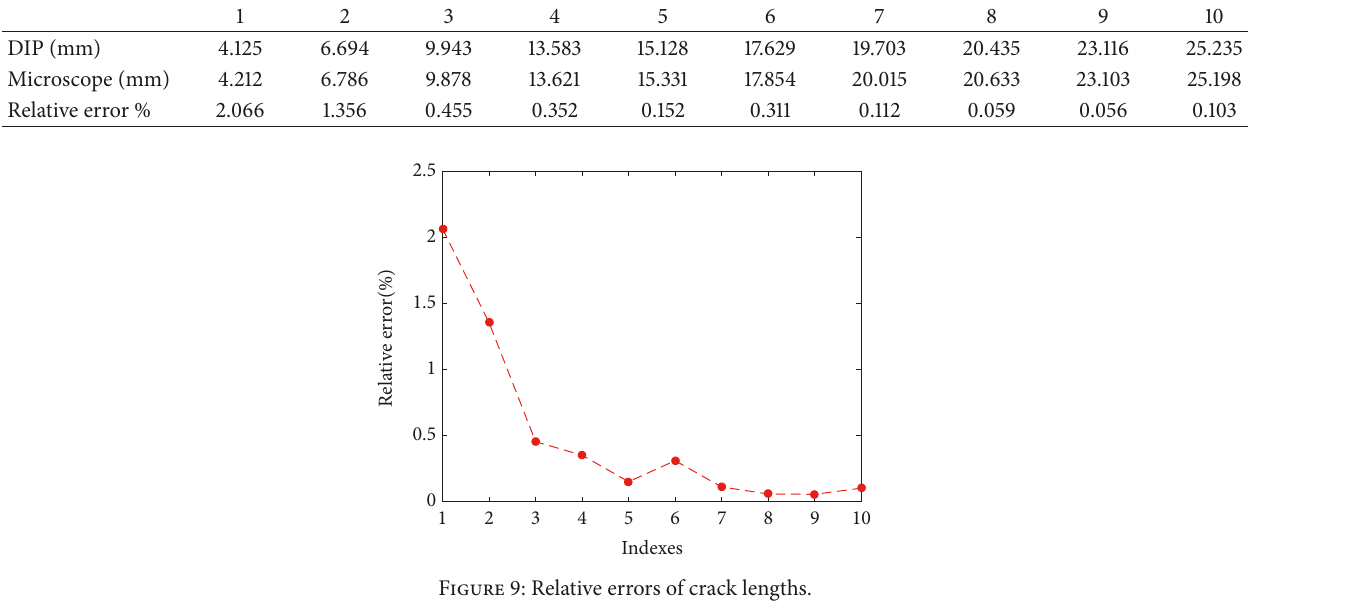
Figure 9: Relative errors of crack lengths.